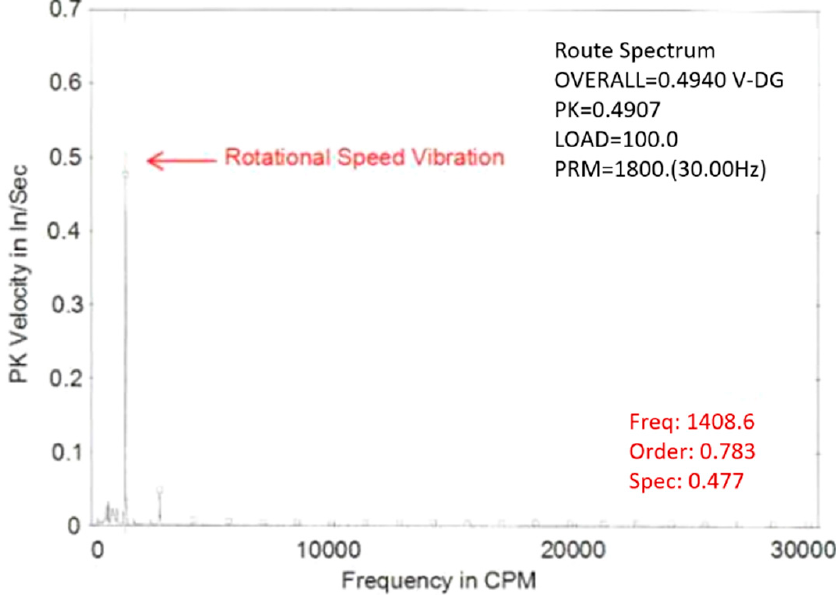
Figure 6. Car engine vibration spectrum at the container location with a 0.477 inches/second peak velocity at the frequency of 1408.6 cycles per minute.